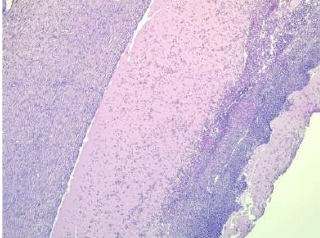
Figure 5. High level of inflammatory infiltrate at six weeks after surgery.